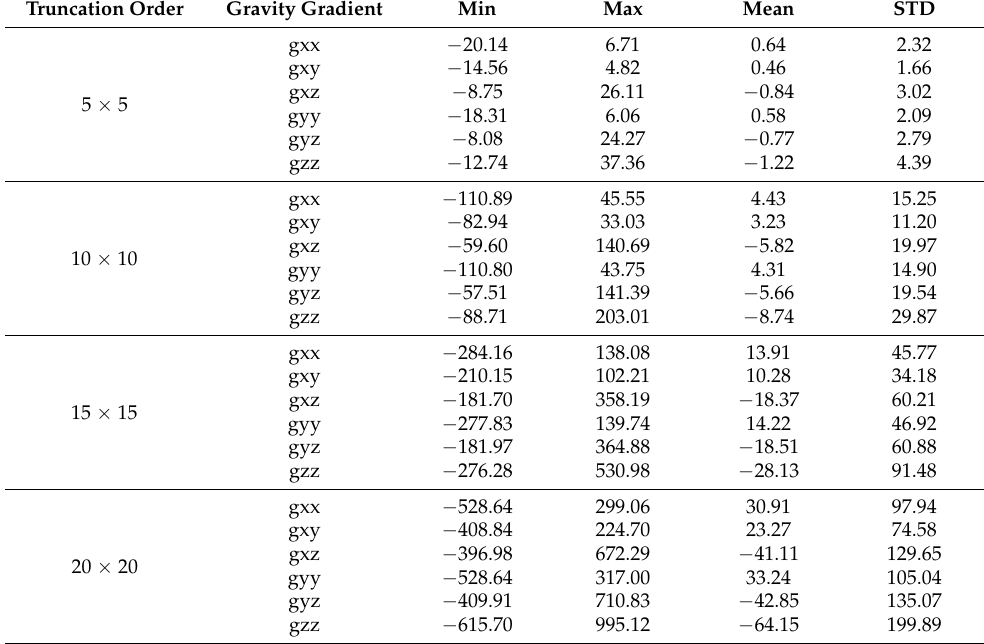
Table 3. Statistical table of experimental results from the North China Plain. Unit: E (Eötvös).